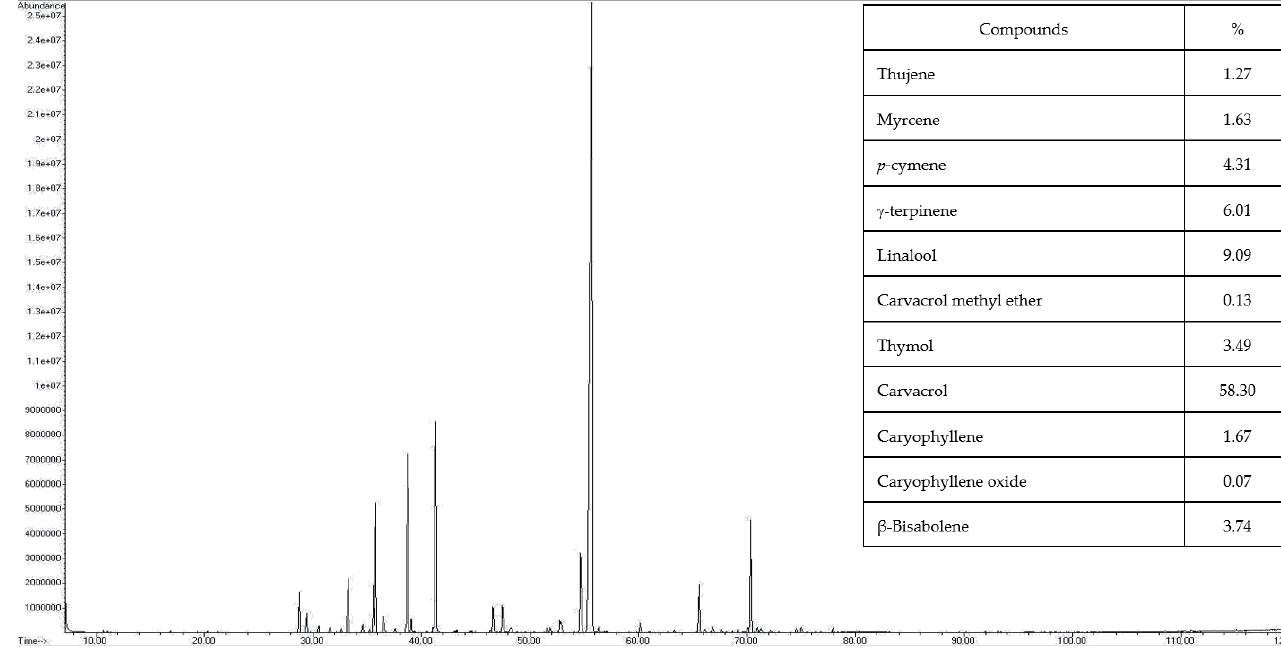
Figure 1. Oregano essential oil chromatogram by GS/MS/MS.